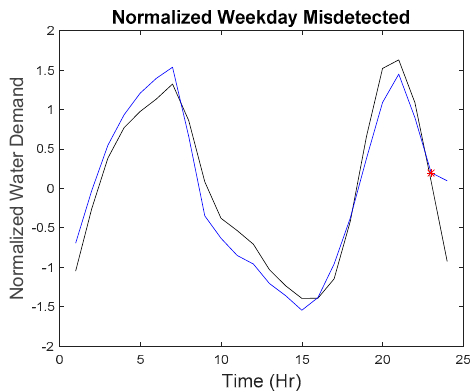
Figure 17. Shape of series with second missed detected anomaly.